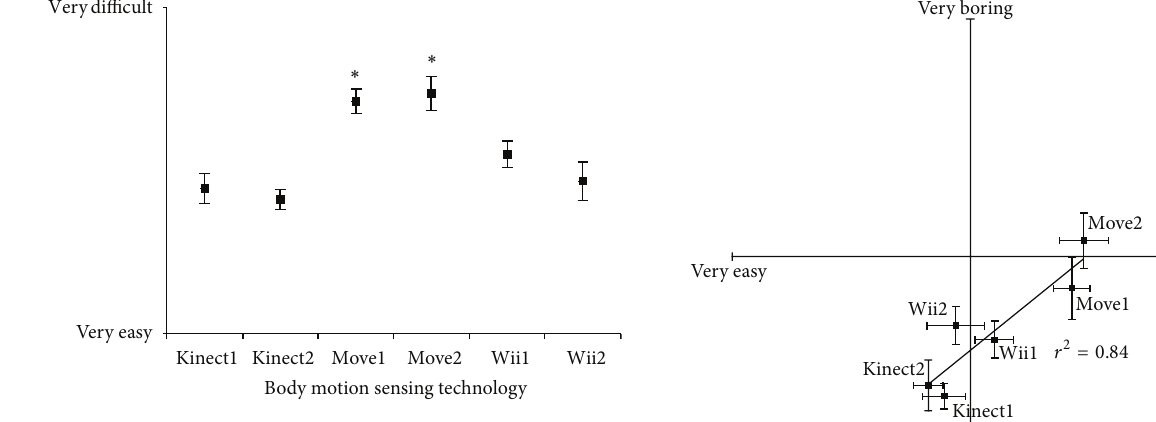
Figure 5: Rating of perceived game difficulty reported immediately after performing each of the different dance routines using the var- ious different body motion sensing technologies. Data are shown as mean ( 𝑛 = 11 ) and error bars indicate SEM. ∗ indicates significantly more difficult versus the other sensing technologies ( 𝑃 < 0.05 ).